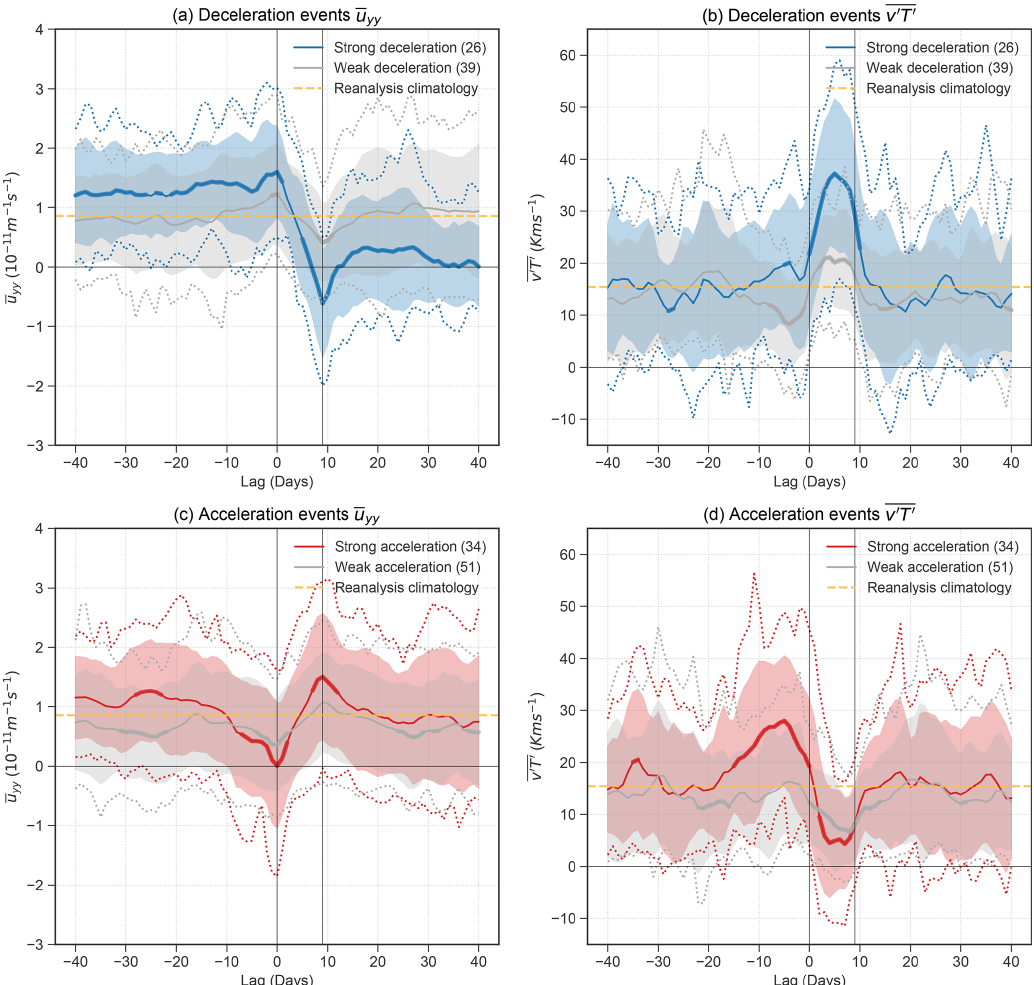
Figure 5. Time evolution of daily values of u yy (a, c) and v (cid:48) T (cid:48) (b, d) for the strong deceleration (blue, a, b ) and acceleration (red, c, d ) events in reanalysis. The solid line is the mean value of all events, and the bold parts of the line indicate lags where the composites are significantly different from the reanalysis winter climatology (dotted yellow lines) at 95% using Student’s t test. Weak events are composited separately and shown in grey. The dotted lines in the corresponding colours indicate the 5th and 95th percentiles of the composite, and the shaded regions indicate the 25th to 75th percentiles. The numbers in the brackets of the legend indicate the number of events in each composite. Lag is relative to the first day of the identified 10d